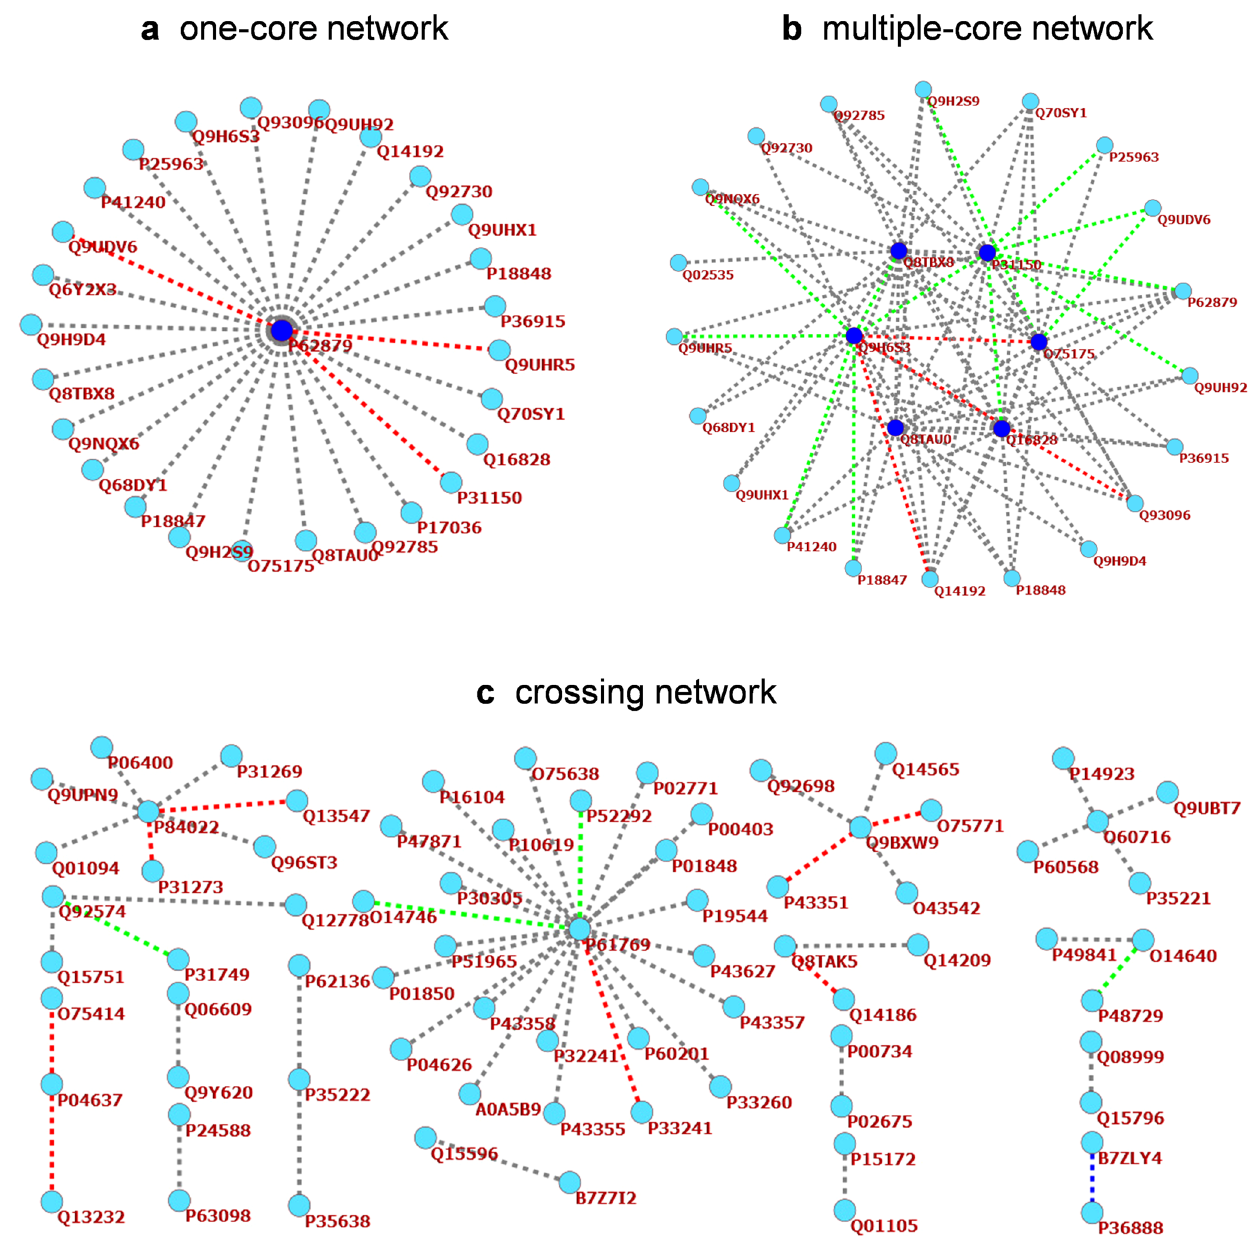
Fig. 1 PPNI network prediction results. a A one-core network involving P62879. b A multiple-core network involving the Q8TBX8-O75175-P31150- Q16828-Q8TAU0-Q9H6S3 pathway. c A crossing network. The core and satellite proteins are represented by indigo blue circles and light blue circles, respectively. Dotted lines connecting two proteins are divided into four classes: gray, predicted correctly; red, predicted falsely; green, re-predicted correctly after adding 40% non-interactions, blue, re-predicted falsely after adding 40% non-interactions. Table 2 Five-fold cross-validation results on the constructed dataset.